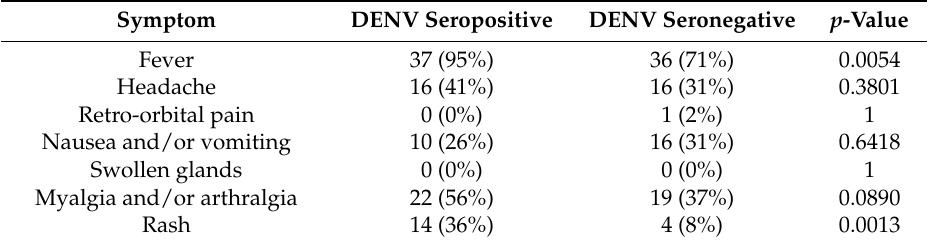
Table 5. Number of patients who presented with symptoms of dengue, as defined in the 2009 World